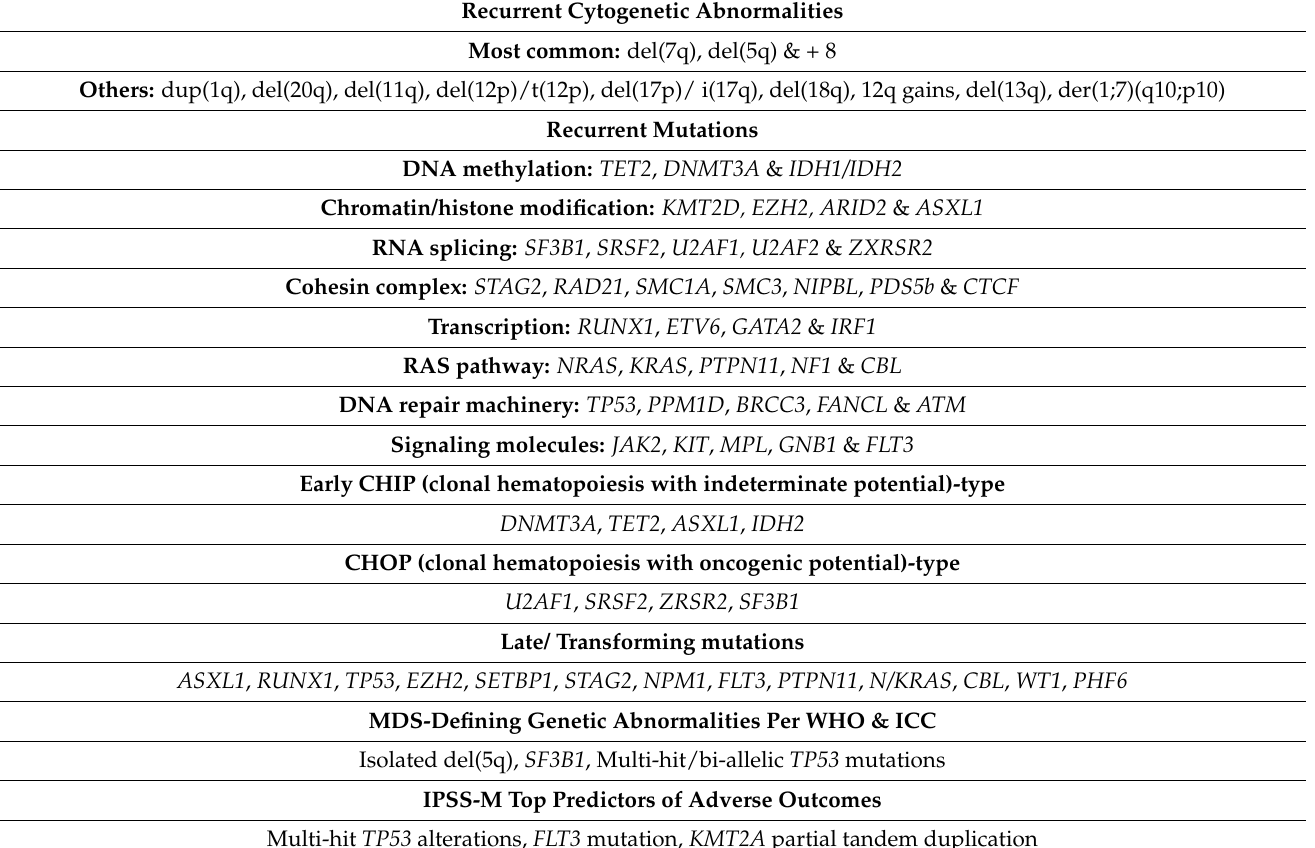
Table 2. Key genetic landscape in myelodysplastic neoplasms (MDS). Recurrent abnormalities can be broadly divided into mutations and cytogenetic aberrations. The most common cytogenetic alterations include del(7q), del(5q) & trisomy 8. Recurrent mutations in MDS affect several cellu- lar pathways and functions, most commonly DNA methylation, chromatin/histone modification, RNA splicing, cohesion complex, the RAS pathway, DNA repair machinery, and several signaling molecules. Recurrent mutations can be further divided into early “CHIP (clonal hematopoiesis with indeterminate potential)-type” affecting genes commonly involved in clonal hematopoiesis, “CHOP (clonal hematopoiesis with oncogenic potential) -type,” and late and/or transforming events that affect genes not classically associated with clonal hematopoiesis. Three genetic events are MDS class-defining according to the 5th edition of the World Health Organization (WHO) classification and the International Consensus Classification (ICC), these include isolated del(5q), SF3B1 mutations and multi-hit/bi-allelic TP53 alterations. The International Prognostic Scoring System-Molecular (IPSS-M) identifies multi-hit TP53 alterations, FLT3 mutations, and KMT2A partial tandem duplication as the top three genetic predictors of leukemic transformation and adverse outcomes in patients with MDS. Recurrent Cytogenetic Abnormalities Most common: del(7q), del(5q) & + 8 Others: dup(1q), del(20q), del(11q), del(12p)/t(12p), del(17p)/ i(17q), del(18q), 12q gains, del(13q), der(1;7)(q10;p10) Recurrent